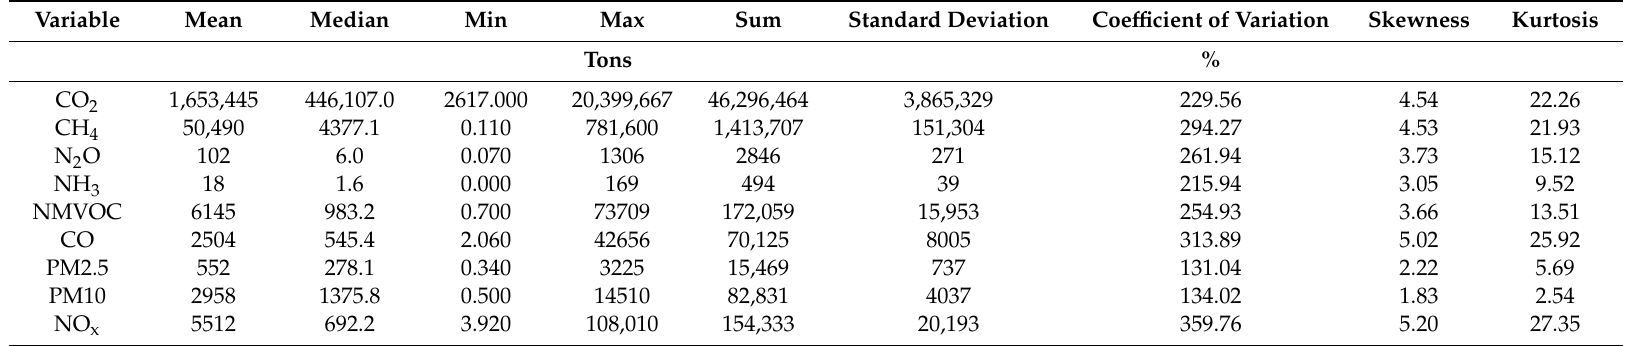
Table 4. Basic statistical parameters of the absolute emission values of studied substances (own elaboration).